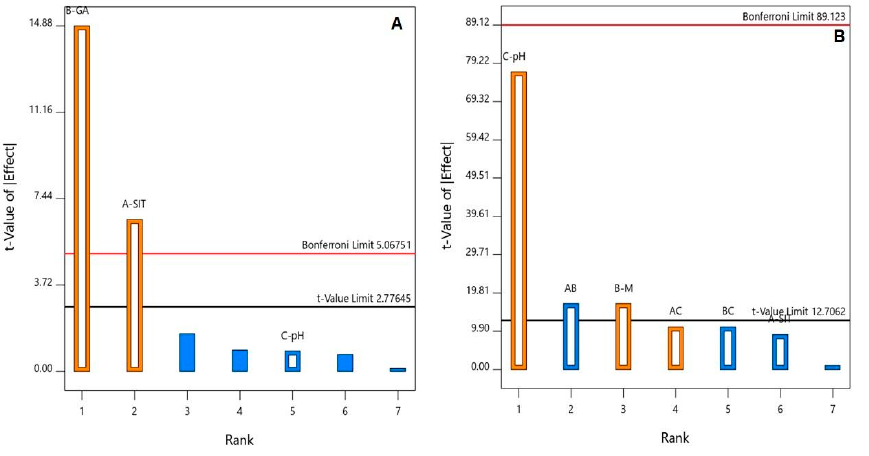
Figure 1. Standardized Pareto chart for the ( A ) particle size and ( B ) zeta potential of the SIT-GA nano-conjugates.